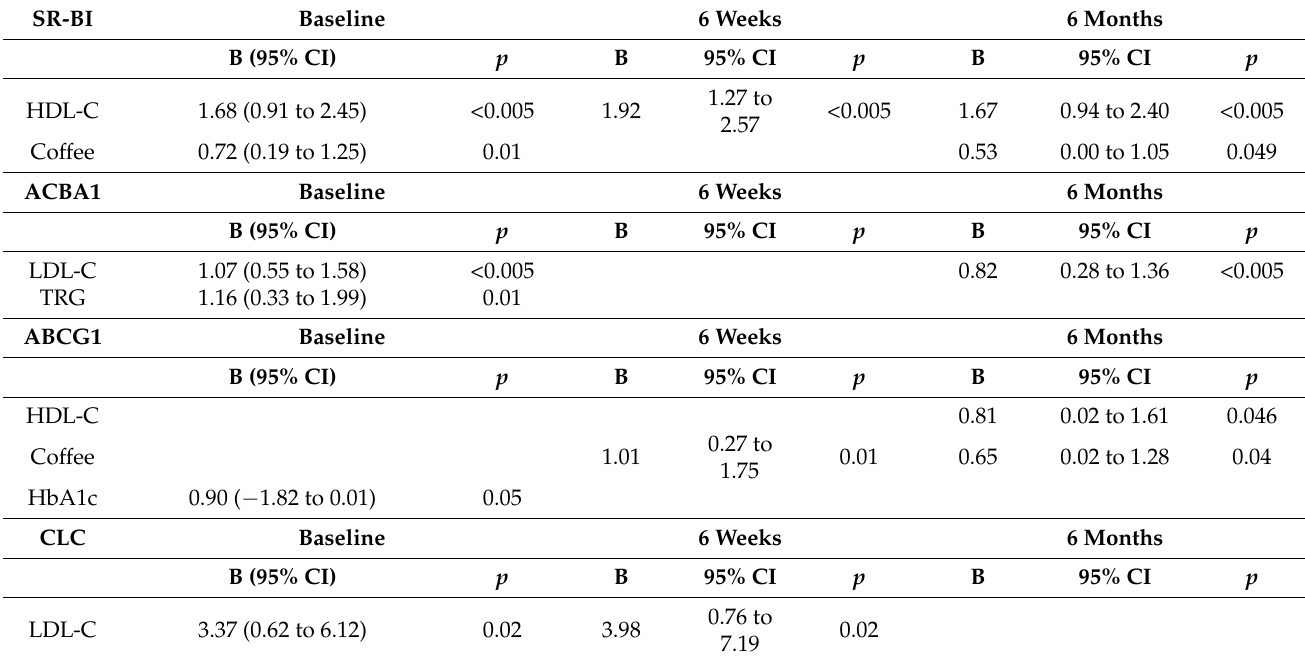
Table 4. Adjusted regression analyses: Variables with a statistically significant association to choles- terol transport parameters at baseline, 6 weeks, and at 6 months.